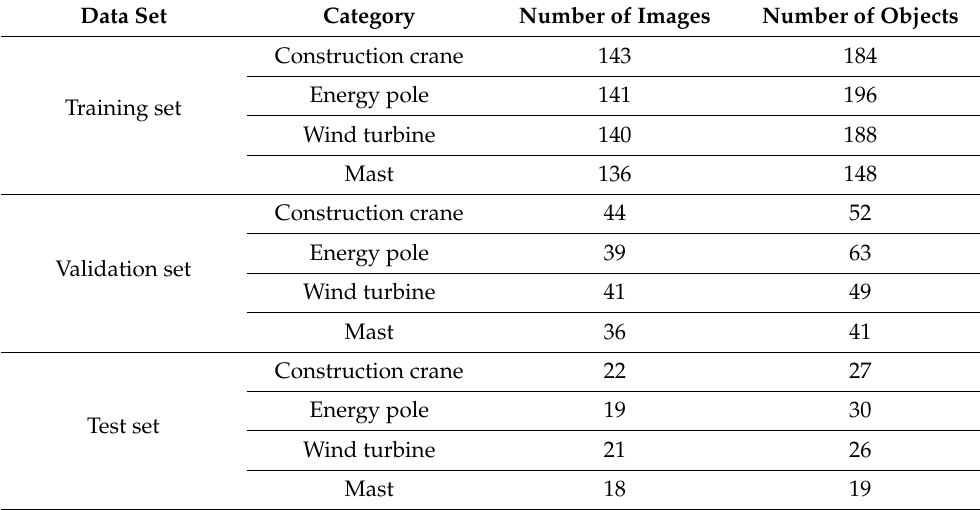
Table 2. Contents of the data set.